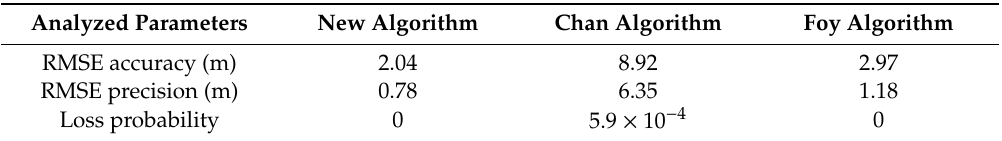
Figure 6. Comparative analysis of performance of ( a ) the new algorithm, ( b ) the Chan algorithm, ( c ) the Foy algorithm, and ( d ) the cumulative distribution functions of position errors when all devices were deployed inside an inhabited single-family house. Table 1. Results of comparative analysis when all devices where deployed inside an inhabited single-family